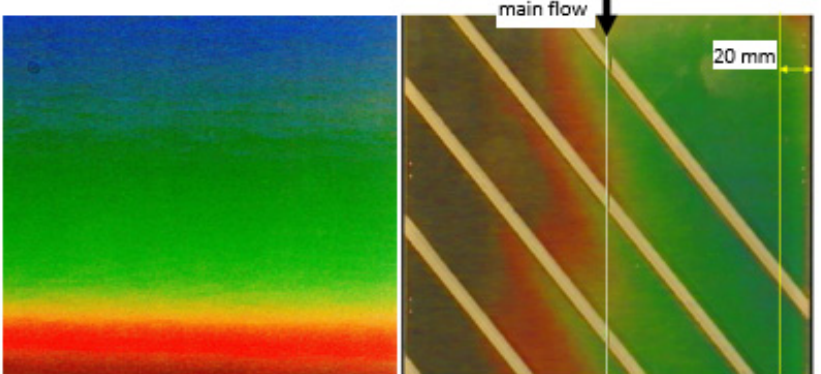
Figure 5. Visualization of the hue (color) distribution field on the flat plate and ribbed surface with marked measurement areas: central and near the site wall (configuration_3).